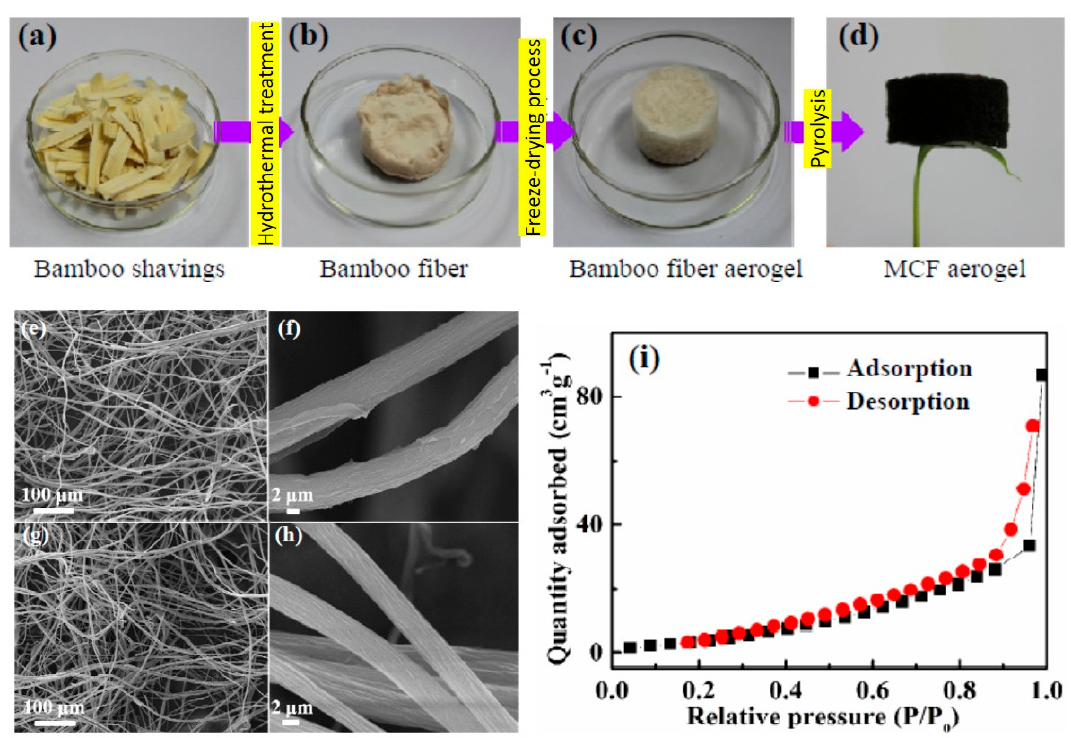
Figure 10. ( a – d ) Preparation of MCF aerogel, ( e , f ) bamboo fiber aerogel; ( g , h ) MCF aerogel, and ( i ) nitrogen adsorption–desorption isotherm of MCF aerogel (adapted and modified from [67] with permission from RSC).